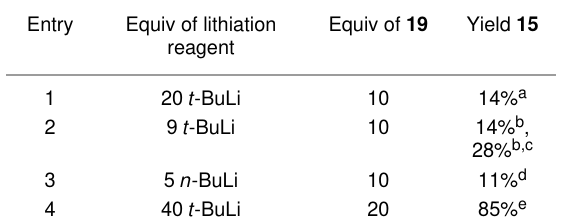
Table 2: Optimization of the HD rearrangement of 19 and subsequent reaction with xanthone 17 to the silicon rhodamine dye 15 .